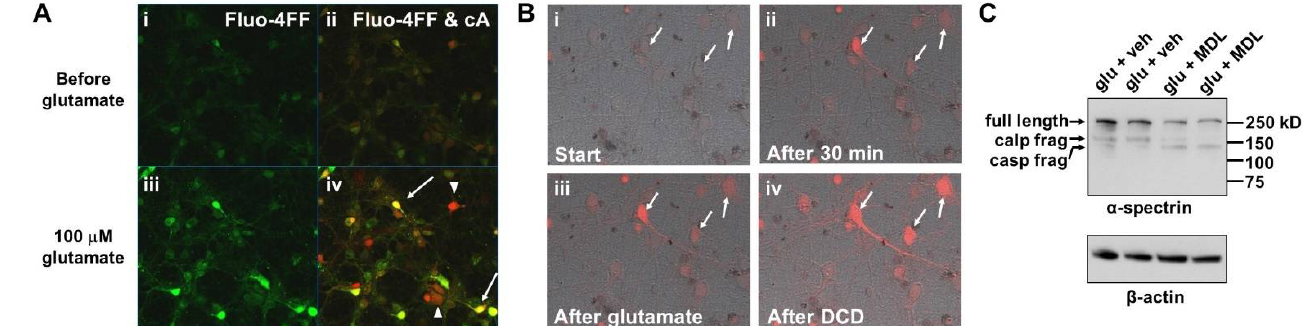
Figure 2. Excitotoxic glutamate (glu, 100 µM) treatment causes intracellular cA fluorescent product to accumulate prior to delayed Ca 2+ deregulation (DCD), both in the absence ( A ) and presence ( B ) of the calpain inhibitor MDL28170 (MDL, 20 µM). In A, rat cortical neurons were simultaneously imaged for Fluo-4FF fluorescence (green, panel i) and cA fluorescence (red, merged with Fluo-4FF, panel ii) at 4 min prior to glutamate addition. Panels iii and iv in A show the same field of neurons imaged under the respective fluorescence channels at two hours post-glutamate exposure. In B, rat cortical neurons were imaged after a 30 min pre-incubation with MDL28170 and cA (panel i), imaged again after 30 min (panel ii, just prior to glutamate addition), imaged four minutes after glutamate exposure (panel iii), and imaged at two hours post-glutamate exposure (panel iv). The cA fluorescent signal (red) is shown as an overlay on the phase contrast images. The three cells indicated by arrows underwent DCD in the interval between when the images in panels iii and iv were taken, as identified by simultaneous Fluo-4FF imaging (not shown). ( C ) Western blot showing detection of the calpain substrate α-spectrin in cells pre-treated with MDL28170 or vehicle and then exposed to glutamate. Arrows denote full-length α-spectrin and calpain (calp)- and caspase (casp)-generated α-spectrin cleavage fragments (frag). β-actin was detected on the same membrane as a loading control.